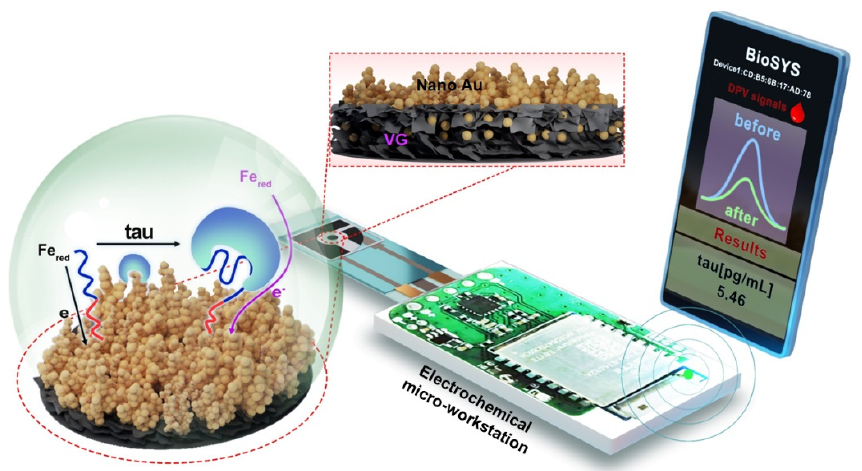
Figure 1. Schematic illustration of electrochemical aptasensing platform based on VG@Au for detecting tau protein.